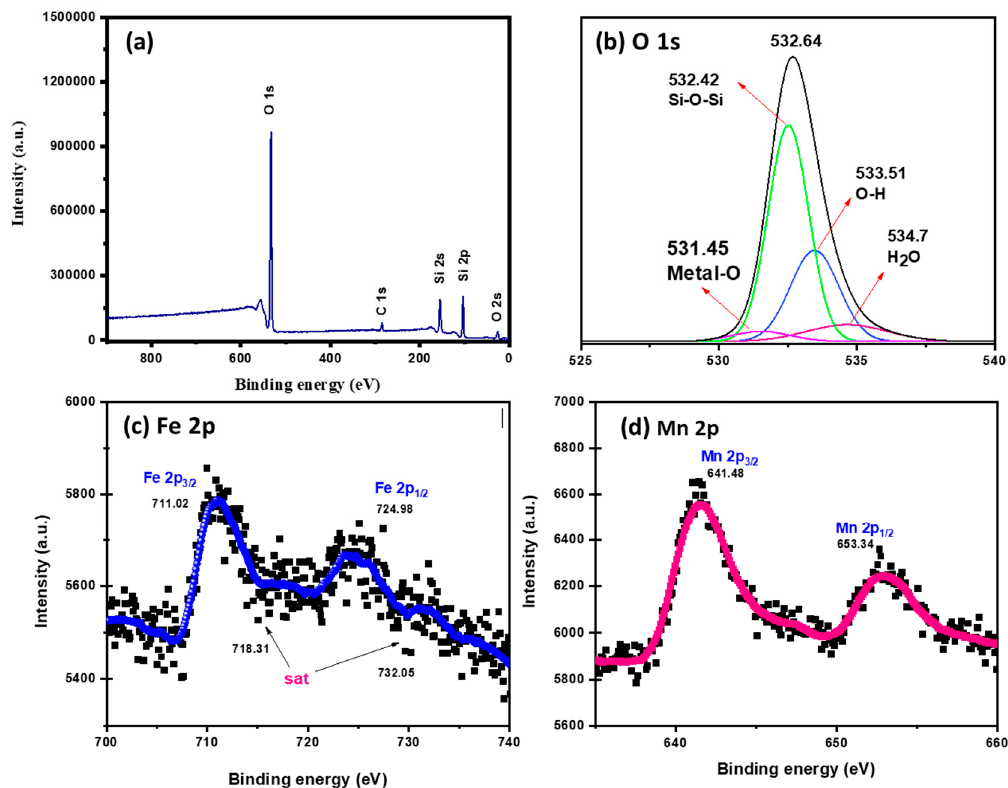
Figure 6. XPS of Fe 2 O 3 /Mn 2 O 3 @SiO 2 (FMS); ( a ) full spectrum of elements, ( b ) O 1s spectrum, ( c ) Fe 2p spectrum, and ( d ) Mn 2p spectrum.